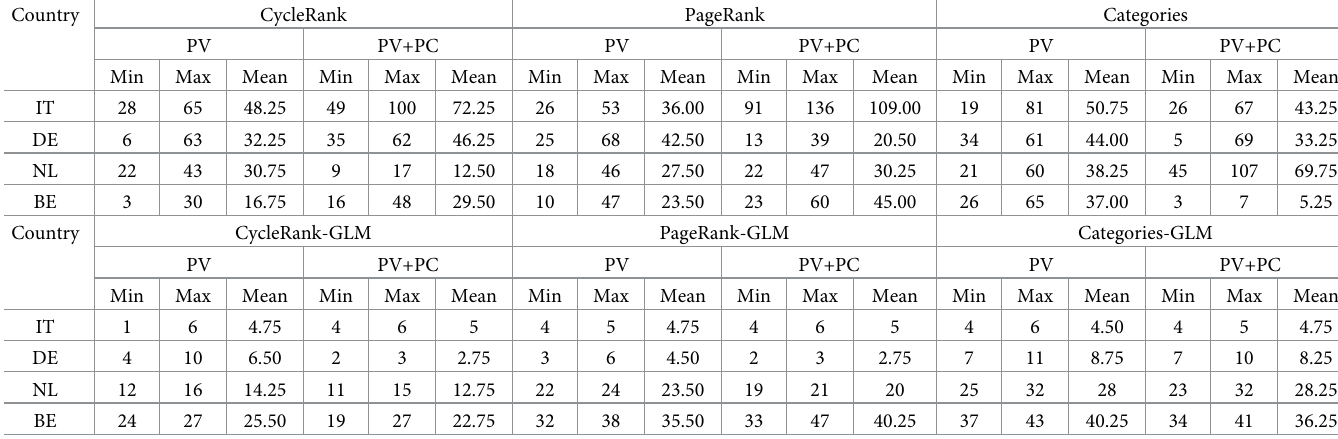
Table 8. Analysis of the number of features selected by the LASSO and GLM models for each influenza season. We record the minimum, the maximum and the mean number of features for all the countries and the different datasets